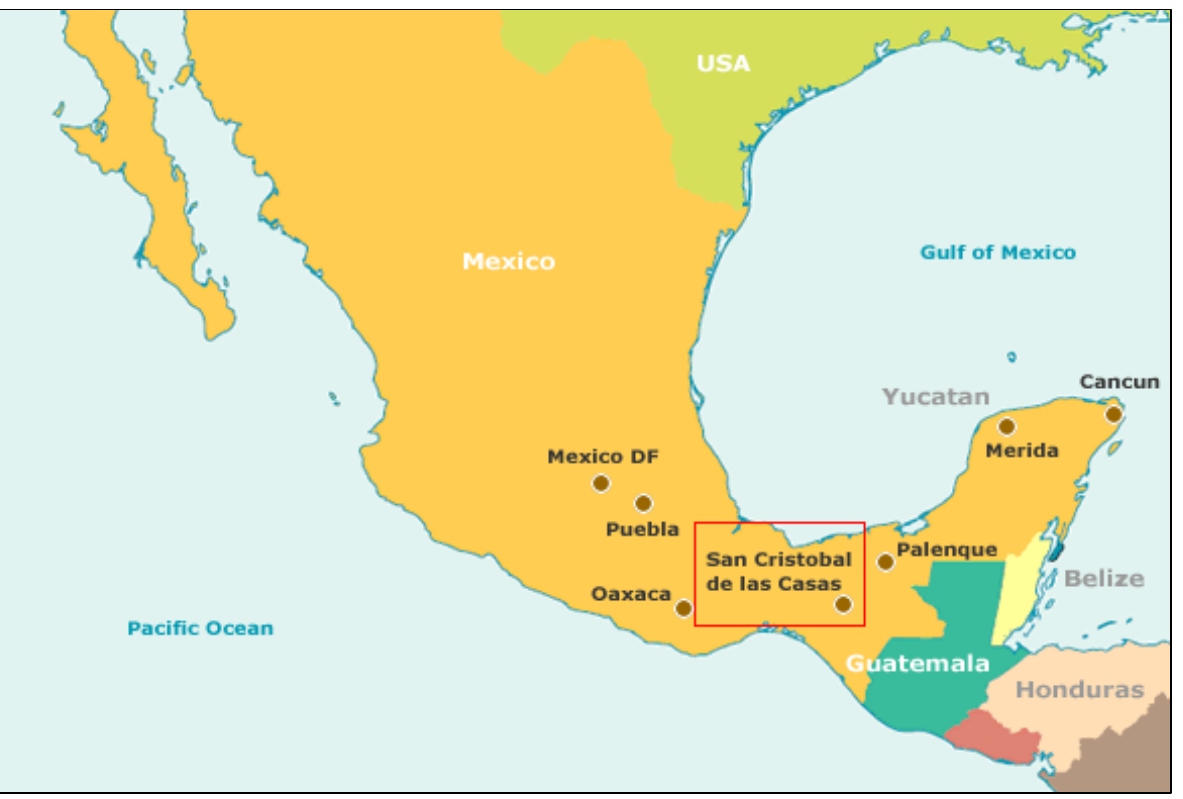
Figure 1. Map of Mexico Indicating Location of San Cristobal de Las